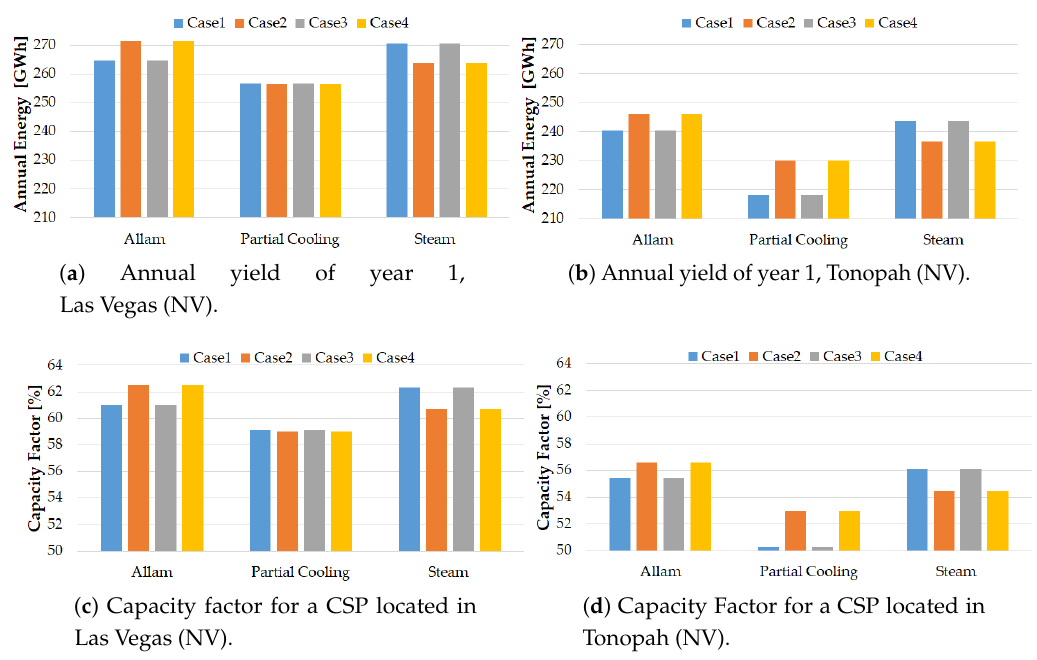
Figure 7. Annual yield and capacity factor for the three power cycles and two locations considered. Designation of cases is explained in Table 6.